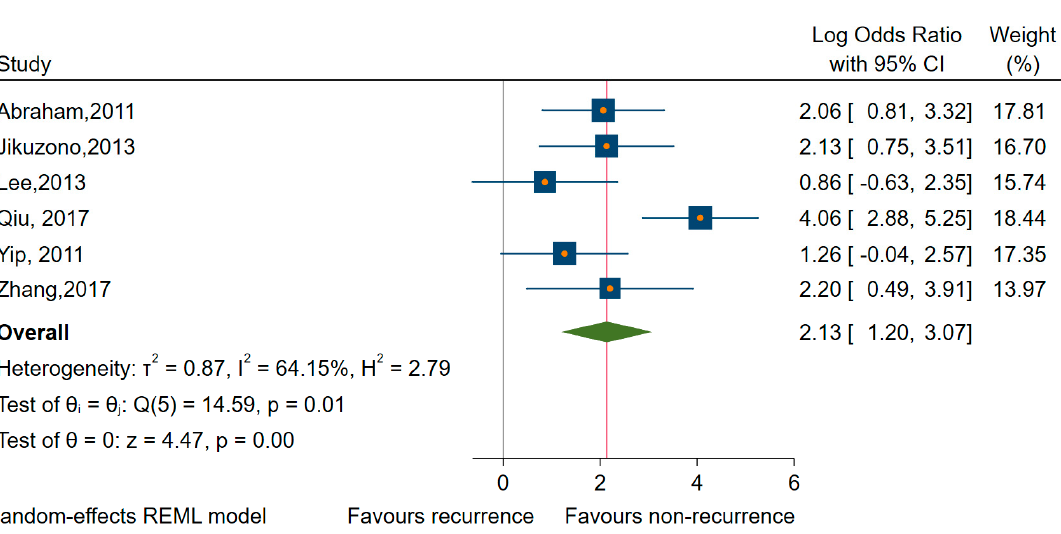
Figure 6. Forrest plot of the association between the upregulated miRNAs and OS. Downregulated miRNAs From all the studies included in meta-analyses, seven pieces of research looked at the low expression of miRNAs as predictors of long-term outcome in TC patients with high heterogeneity between studies [55,59,61,62,65,75,77]. Thus, the random-effects model was applied in subsequent analyses. From all studies, four papers examined the specific relationship with the OS [59,62,65,75]. All miRNA involved (miR-26a, -381, -791, -let 7a) were significantly associated with better OS, with a pooled HR of 0.37, 95% CI 0.24 to 0.60 (log HR = − 0.96, 95% CI: − 1.41 to − 0.50, p < 0.001) and a medium amount of heterogeneity, I 2 = 56% (95% CI 0 to 86) (see Figure 7).